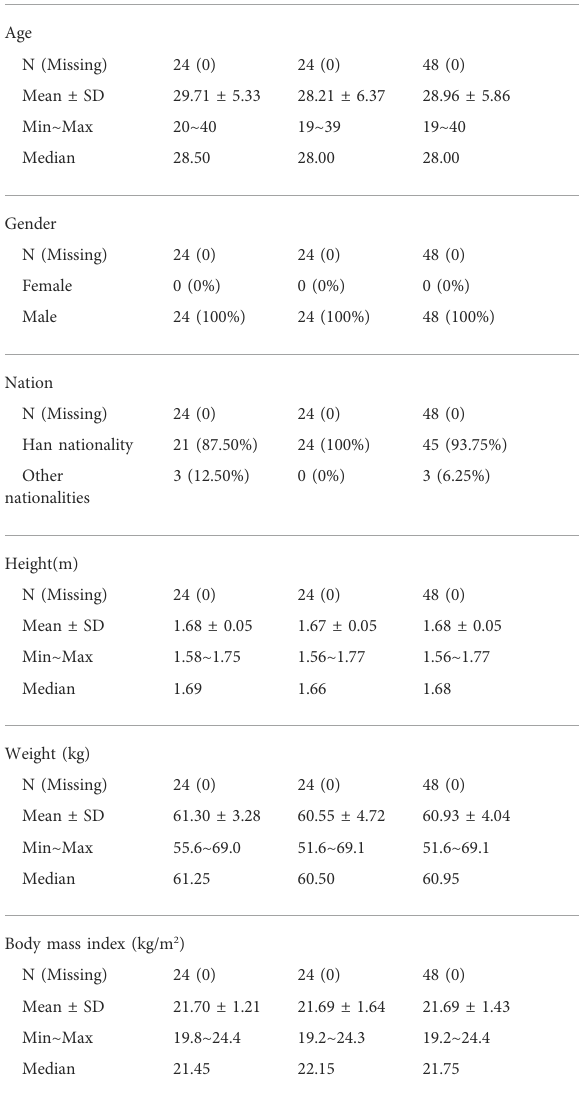
TABLE 1 Basic characteristics of